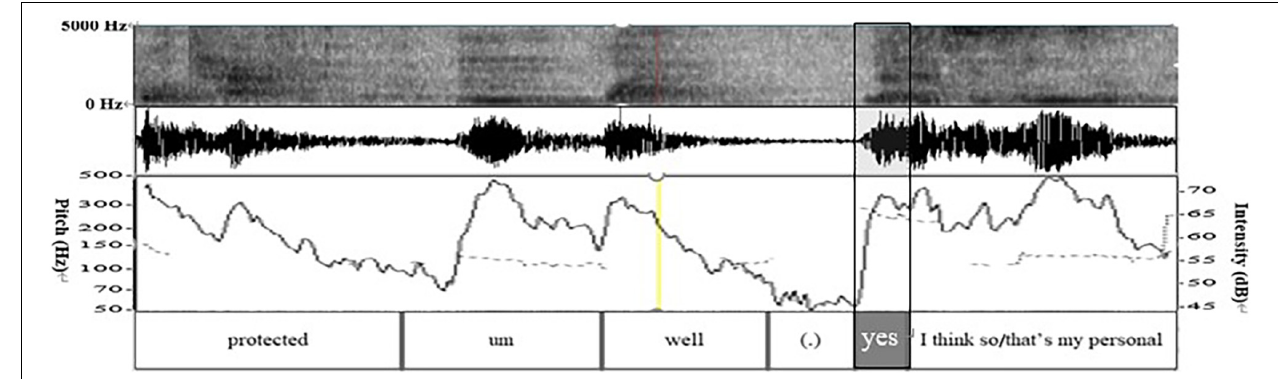
FIGURE 6 | Spectrogram, waveform, pitch trace (dotted line), and intensity trace (solid line) in lines 03–05 in excerpt